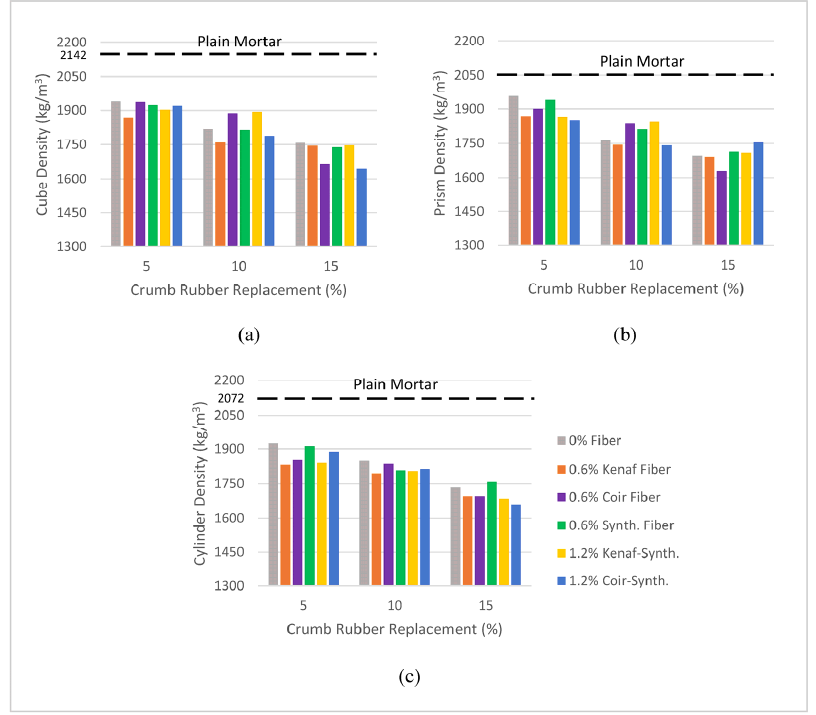
Figure 5. The density of CRM specimens. ( a ) Total cube density. ( b ) Total prism density. ( c ) Total cylinder density.